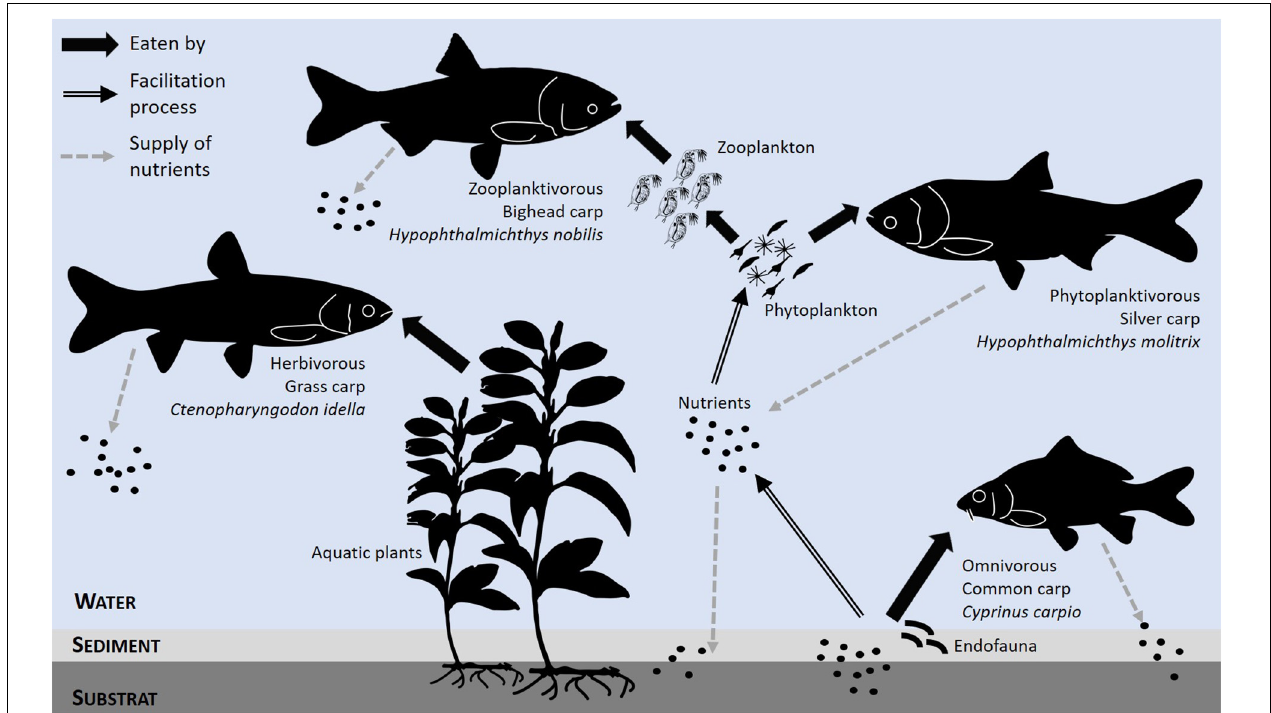
FIGURE 4 | An example of manipulation of the trophic network in the polyculture of cyprinidae, with two objectives: (i) the trophic complementarity of fish species, leading to an effective use of available food resources, and (ii) the exploitation of the facilitation process occurring through the bioturbation of sediments that promotes plankton development on which other fish species rely [adapted from Milstein